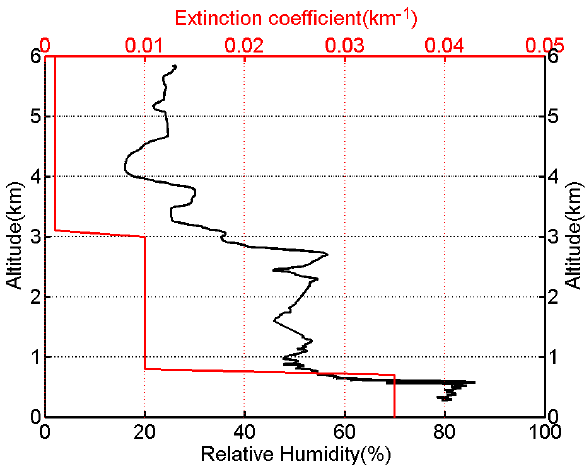
Fig. 5. Construction of the a priori aerosol extinction coefficient profile (red) from the measured relative humidity (black). The extinction values are derived for 350 nm from the software package OPAC, using the Arctic Spring predefined aerosol type.